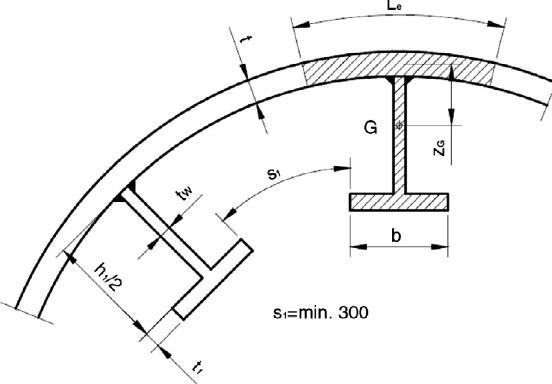
Figure 7. Halved rolled I – section as a stringer